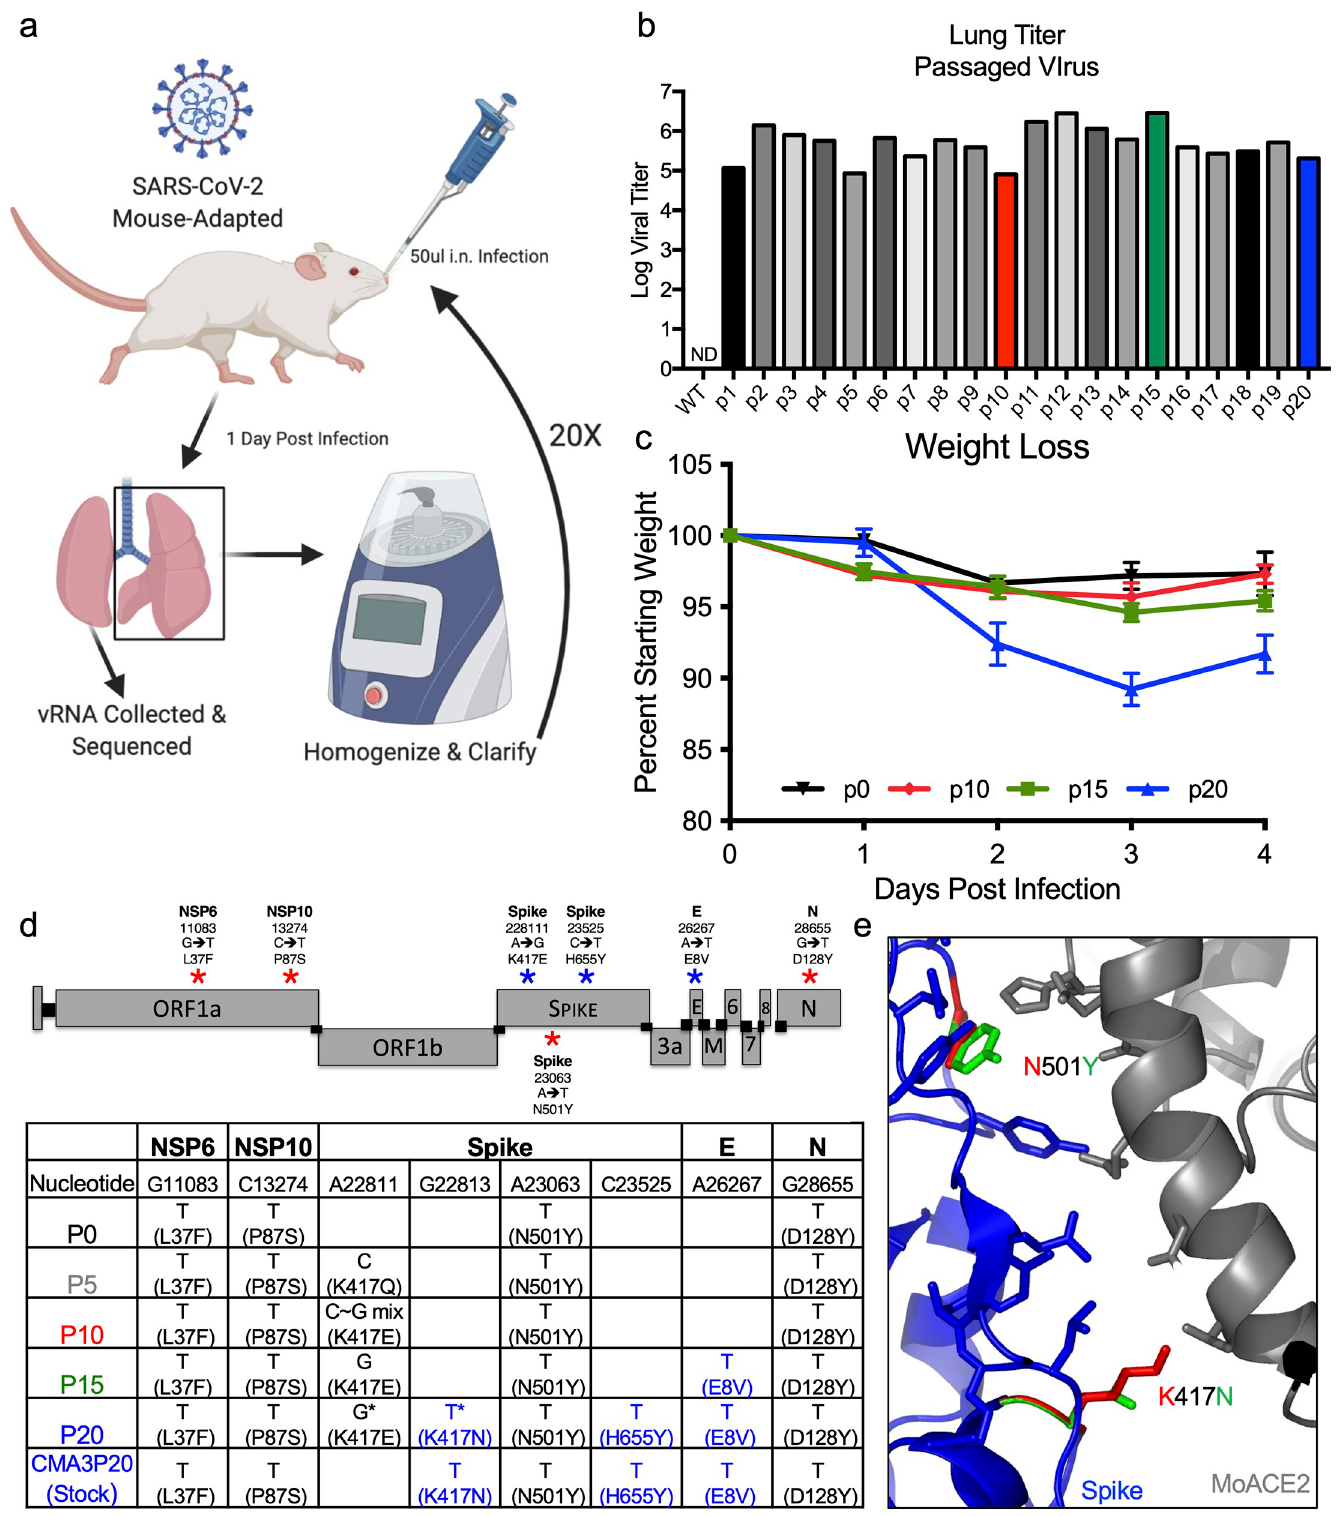
Fig 1. Mouse adaptation of SARS-CoV-2. (a) Schematic of adaptation of SARS-CoV-2 CMA3p20. One 10-week-old female BALB/c mice was infected with SARS- CoV-2 CMA3 for 1 day, euthanized, and lung tissues harvested for viral RNA and viral titer determination. Lung tissues were homogenized, clarified, and 50 ul used to inoculate subsequent animals for 20 p. The figure was generated using BioRender software. (b) Viral replication of CMA3 p1-p20 from lung homogenates isolated from